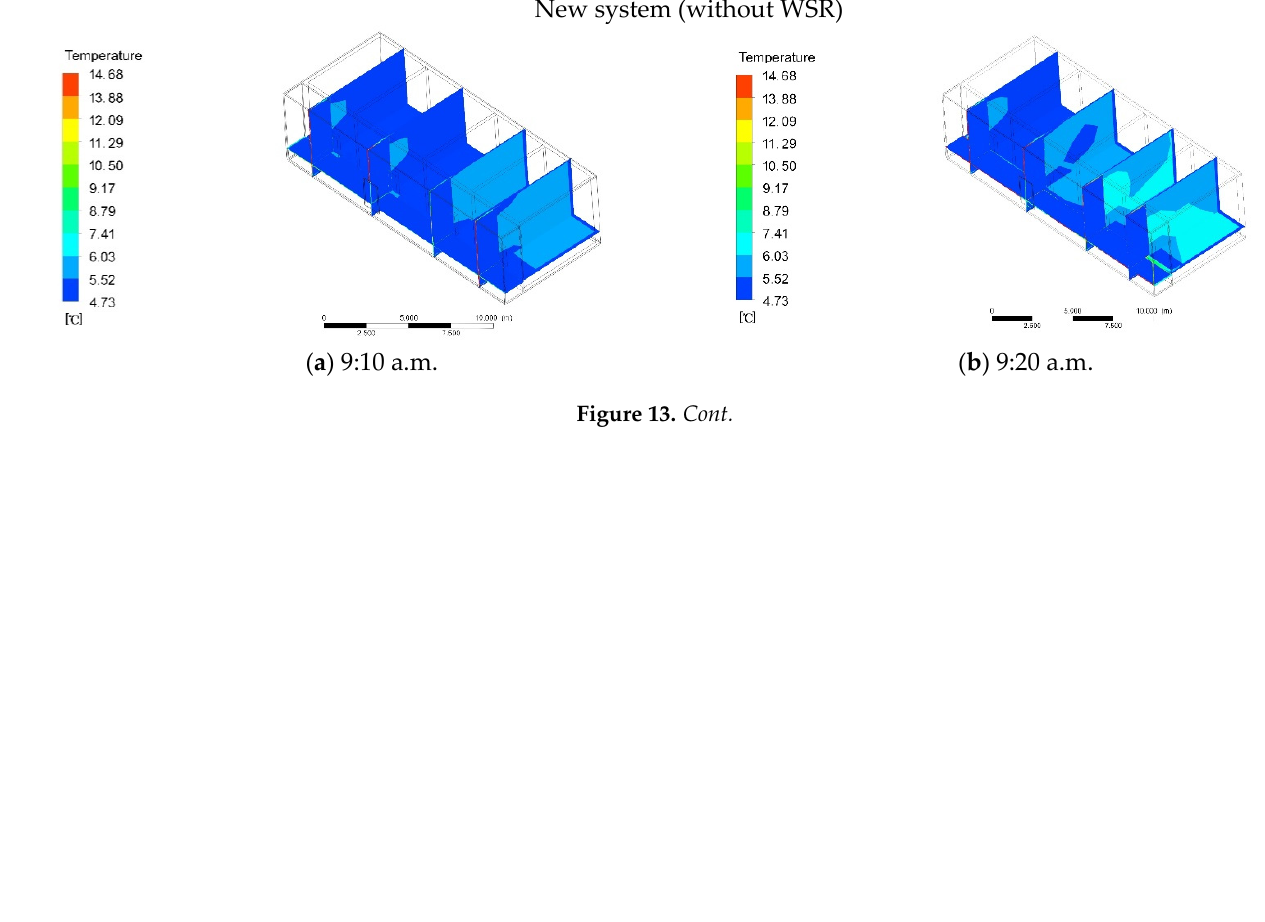
24 of 34 Figure 12. ( a ) At 9:10 a.m. the temperature of the new system (with WSR). ( b ) At 9:10 a.m. the temperature of the new system (with WSR). ( c ) At 9:30 a.m. the temperature of the new system (with WSR). ( d ) At 9:34 a.m. the temperature of the new system (with WSR). ( e ) At 10:10 a.m. the temperature of the new system (with WSR). ( f ) At 10:30 a.m. the temperature of the new system (with WSR). ( g ) At 10:50 a.m. the temperature of the new system (with WSR). ( h ) At 11:20 a.m. the temperature of the new system (with WSR). ( i ) At 11:36 a.m. the temperature of the new system (with WSR). ( j )At 2:16 p.m. the temperature of the new system (with WSR). ( k ) At 6:00 p.m. the temperature of the new system (with WSR). ( l